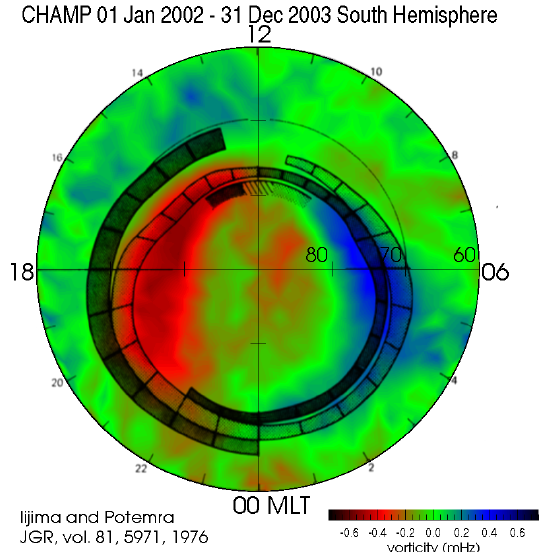
Fig. 2. Same thermospheric vorticity pattern as in Fig. 1, bottom panel, overlayed with the well-known summary of average distribu- tion and flow direction of large-scale field-aligned currents, taken from the paper of Iijima and Potemra (1976, Fig.